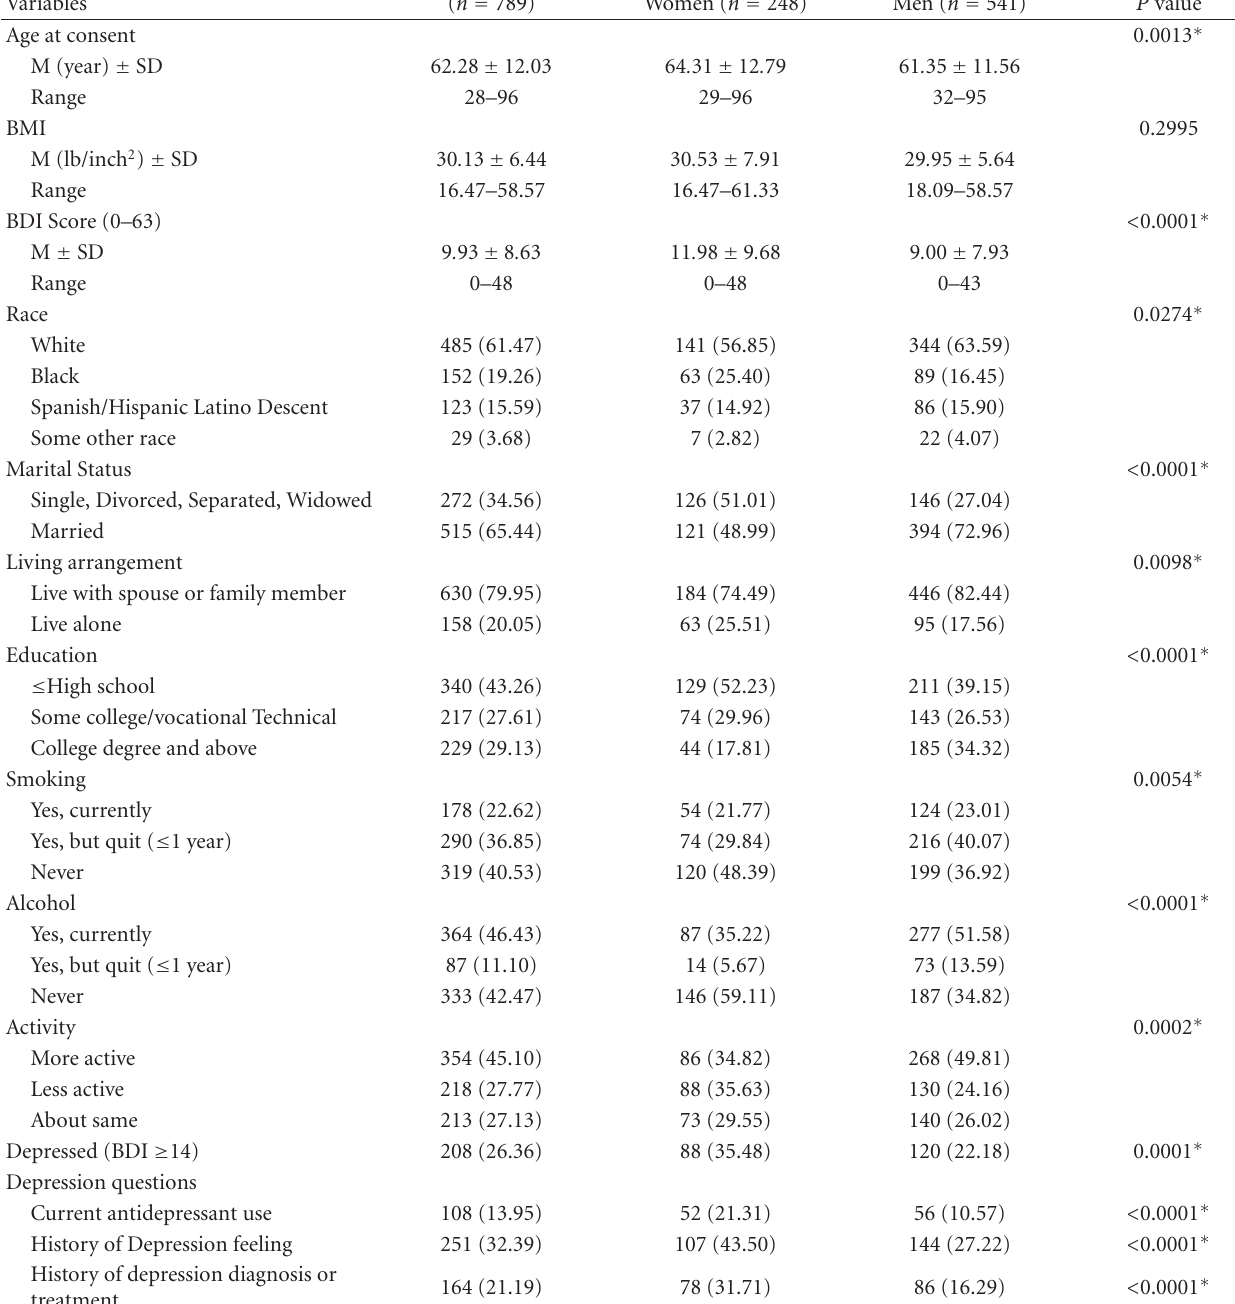
Table 1: Comparison of demographic and clinical health characteristics of acute coronary syndrome